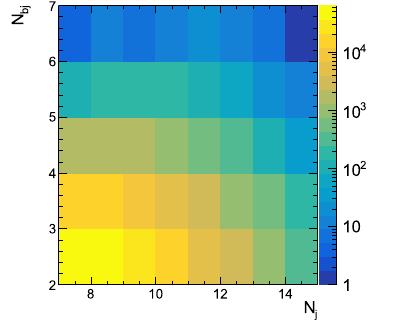
Fig. 3 Plot of ratio of prediction to the truth of the different extrap- olation methods as a function of α together with error bands for the example distribution in Eq. (17)